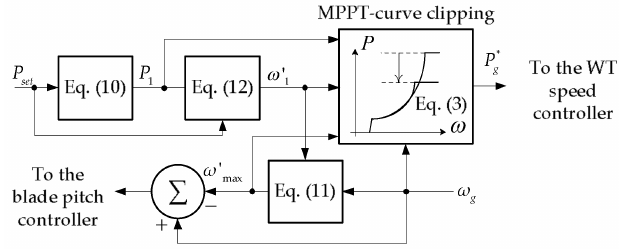
Figure 17. Implementation of the wind power curtailment proposal on the i -th WTC.